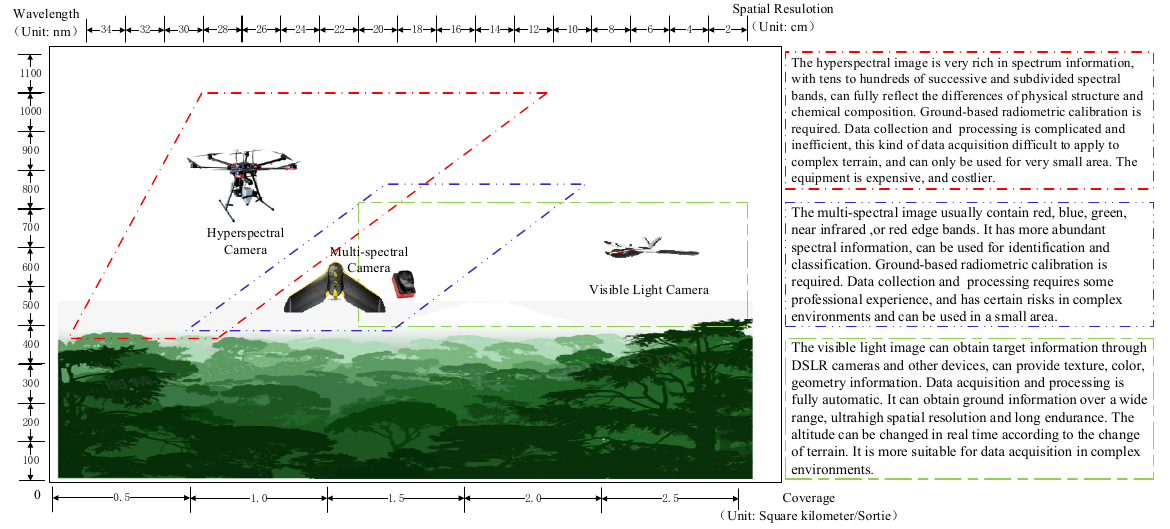
Figure 1. UAV Optical Sensor Features.